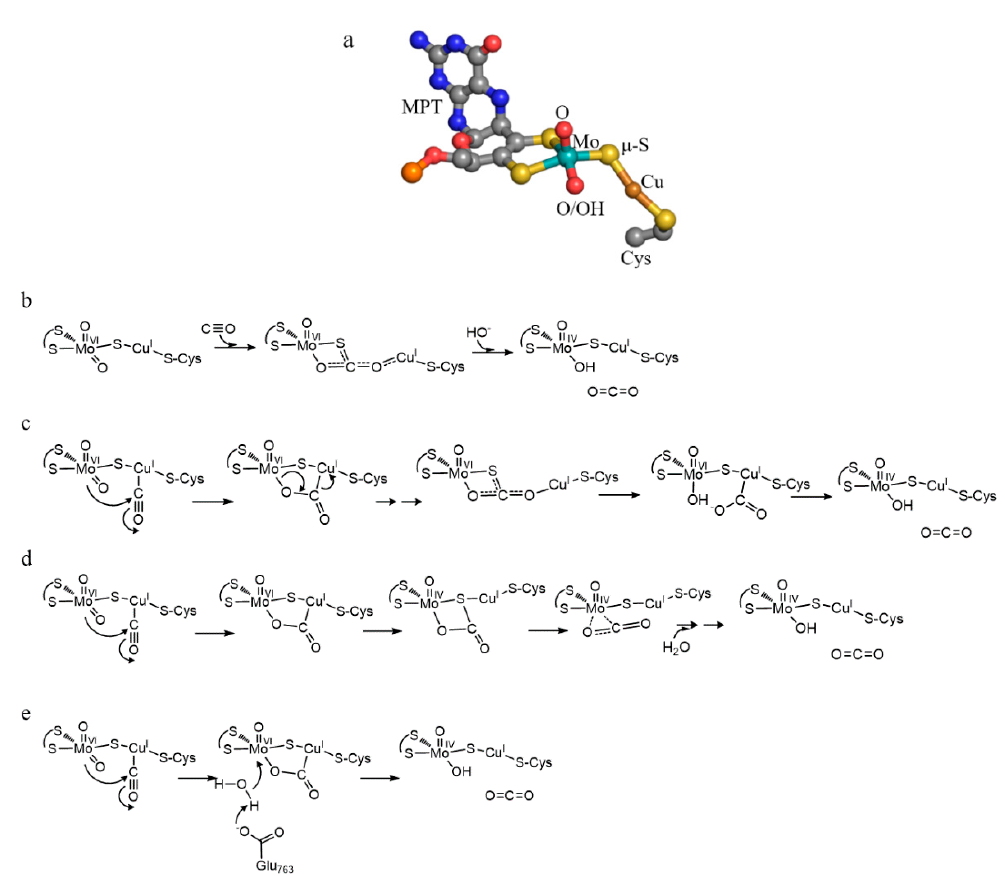
Figure 2. a ) MoCu-CODH active site ( O. carboxidovorans CODH, PDB code 1N5W) and reac- Figure 2. ( a ) MoCu-CODH active site ( O. carboxidovorans CODH, PDB code 1N5W) and reaction pathways proposed by ( b ) Dobbek, ( c ) Siegbahn, ( d ) Hofmann, and ( e )